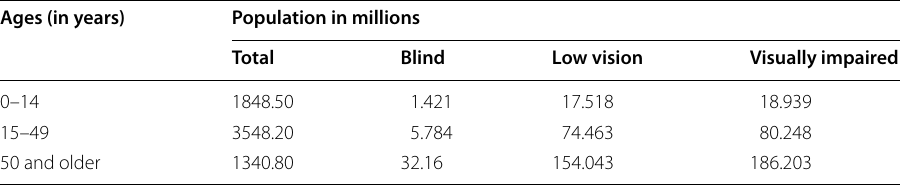
Table 1 Global estimates of the number of people under blind, low vision and visually impaired under different age groups as released by the World Health